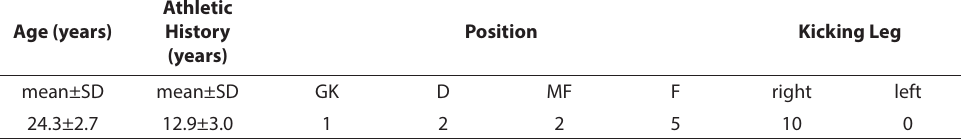
TABLE 1 Descriptive statistics for amateur soccer players